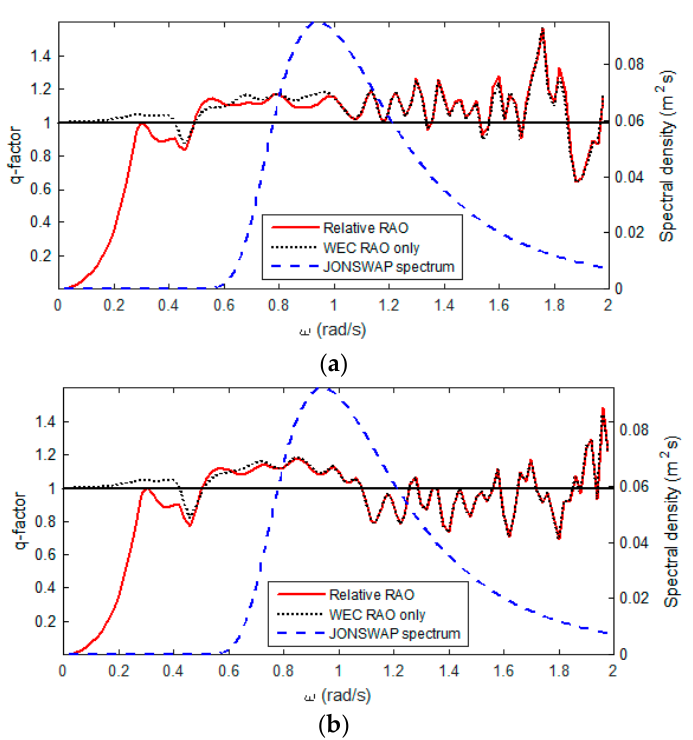
Figure 18. q -factors: ( a ) Wave-heading angle is 0.0 deg; ( b ) Wave-heading angle is 22.5 deg.